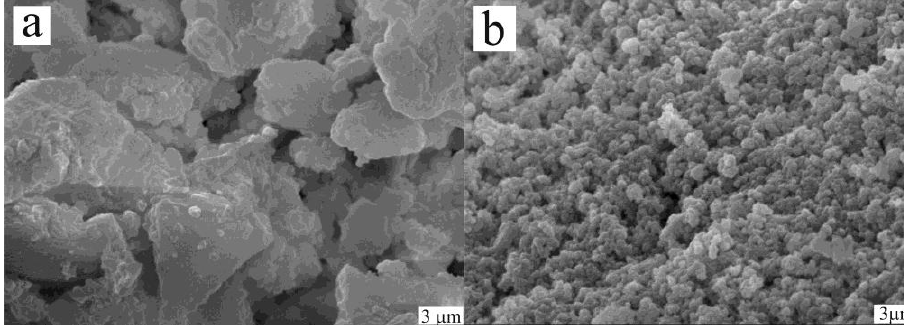
Figure 9. SEM images of the catalyst obtained from (a) Pd(OAc)